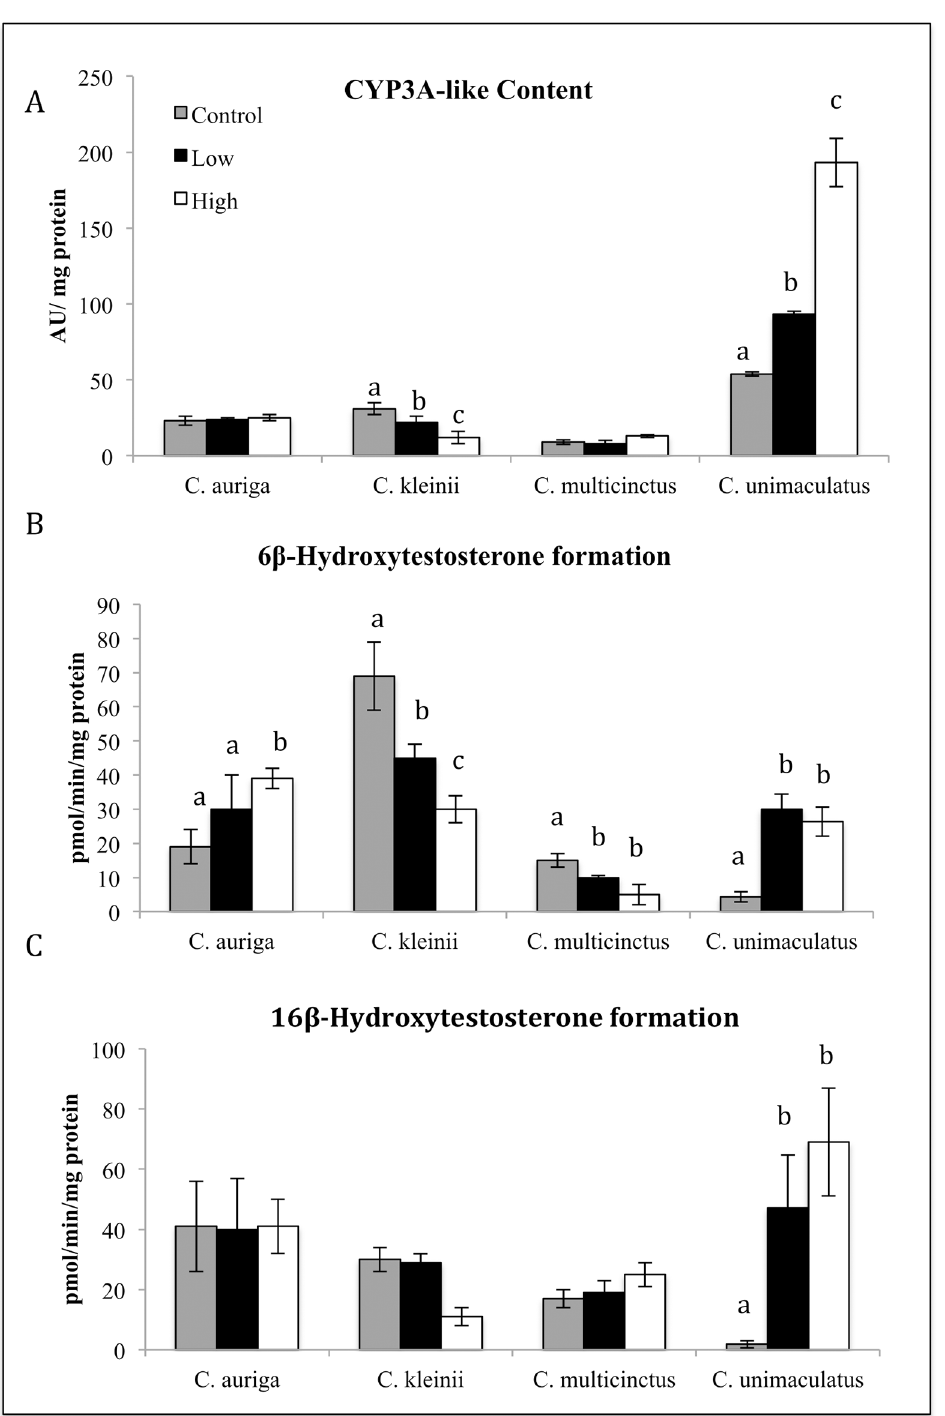
Fig 1. Effects of dietary exposure to S . maxima tissue homogenate on the hepatic content (A) and catalytic activity (B, C) of and CYP3A in four species of butterflyfish. Different letters indicate significant (P (cid:1) 0.05) differences between untreated and treated fish (N = 6 – 8).